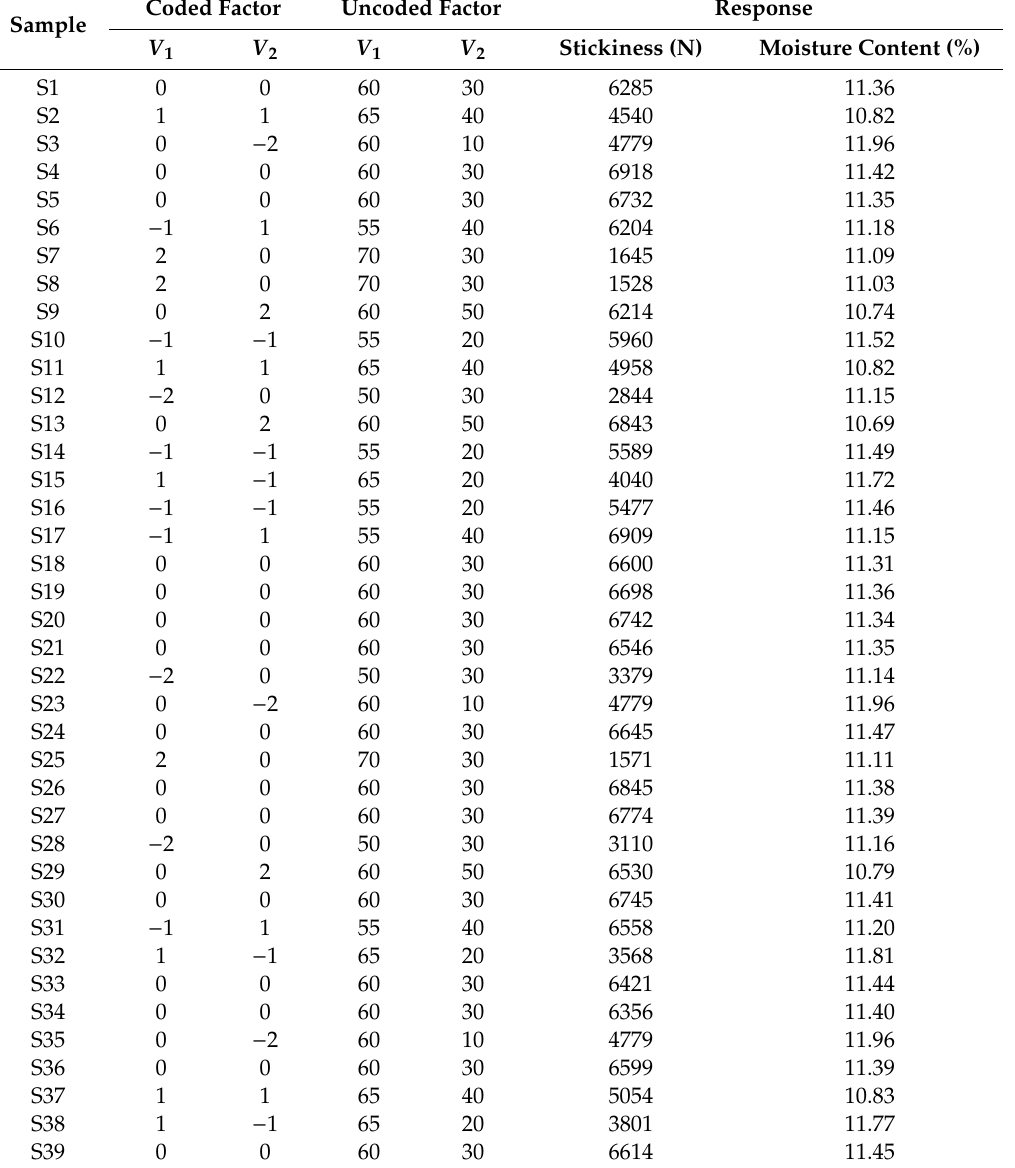
Table 7. Design matrix and response value for the stickiness and moisture content